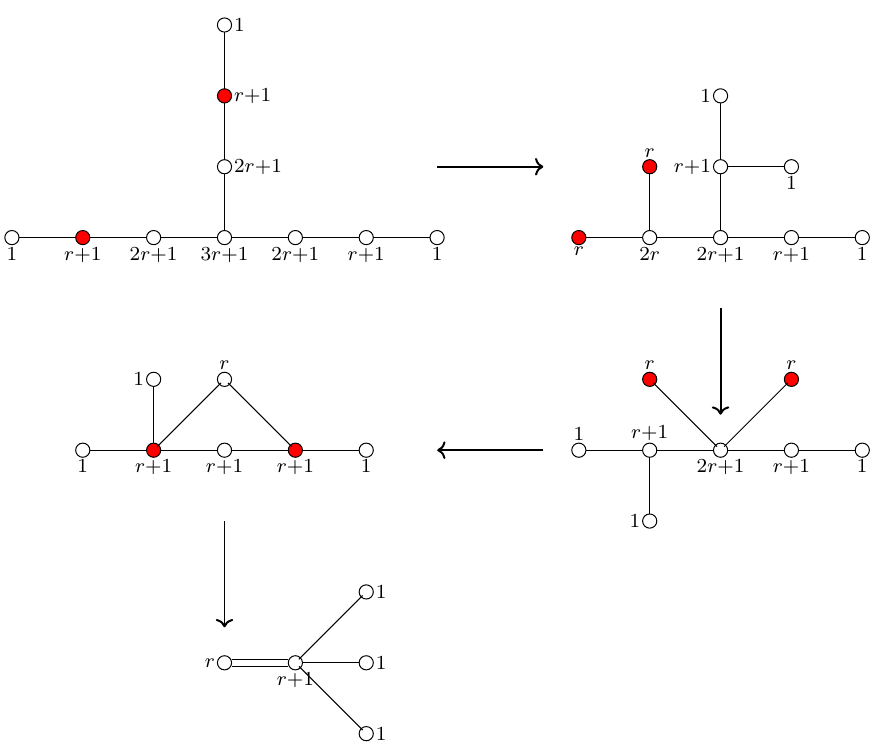
Figure 8. The FI deformations leading from the third quiver in figure 6 to the magnetic quiver of the 5d SCFT which gives the quiver of S ( r )